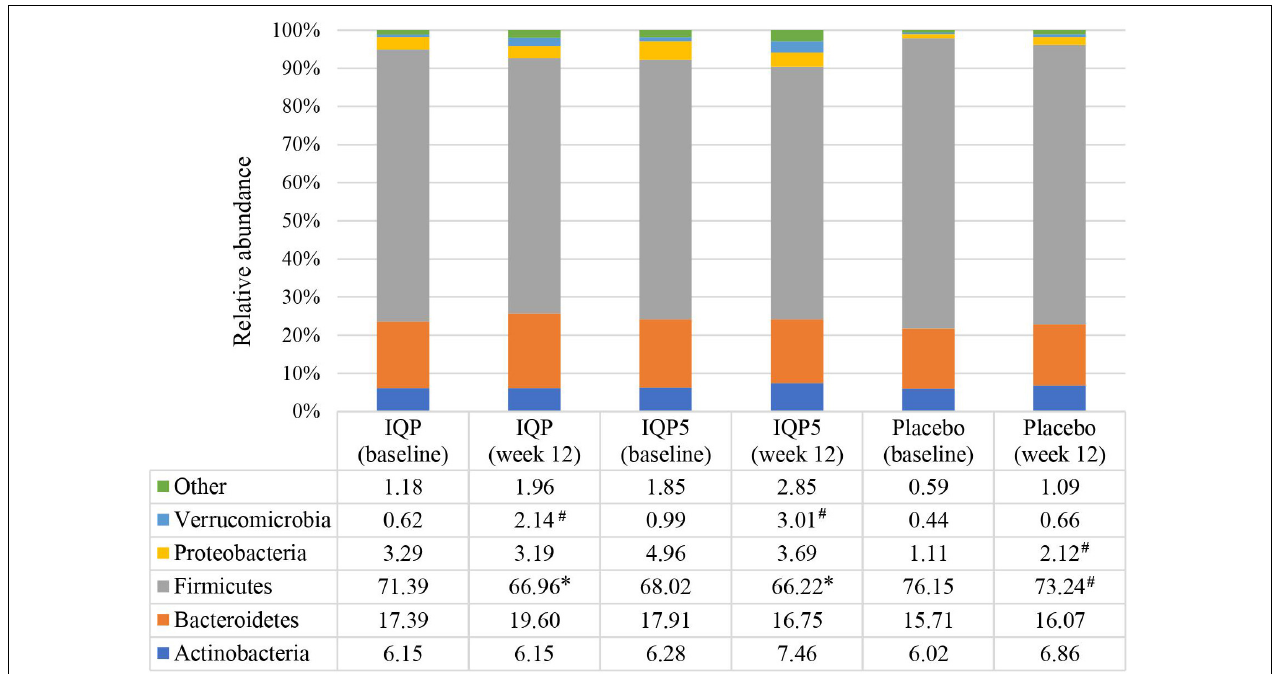
FIGURE 2 | Relative abundance of each phylum at baseline and after 12 weeks is shown as a percentage (%). Pattern-filled columns of the bar chart represent the relative distribution of the five main phyla. Euryarchaeota, Cyanobacteria, Elusimicrobia, Fusobacteria, Lentisphaerae, Spirochaetes, Synergistetes, and Tenericutes are classified as “Other” due to a low abundance level of < 1.0%. ∗ p < 0.05 compared with placebo; # p < 0.05 compared with baseline within the same